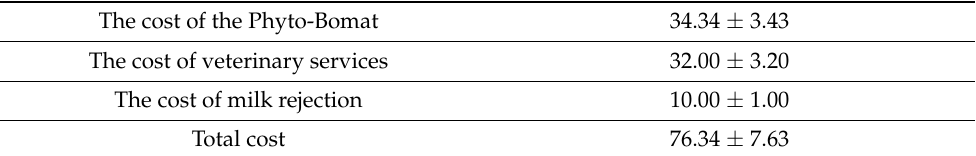
Table 5. Total cost of Phyto-Bomat therapy per cow per episode of mastitis expressed in euros